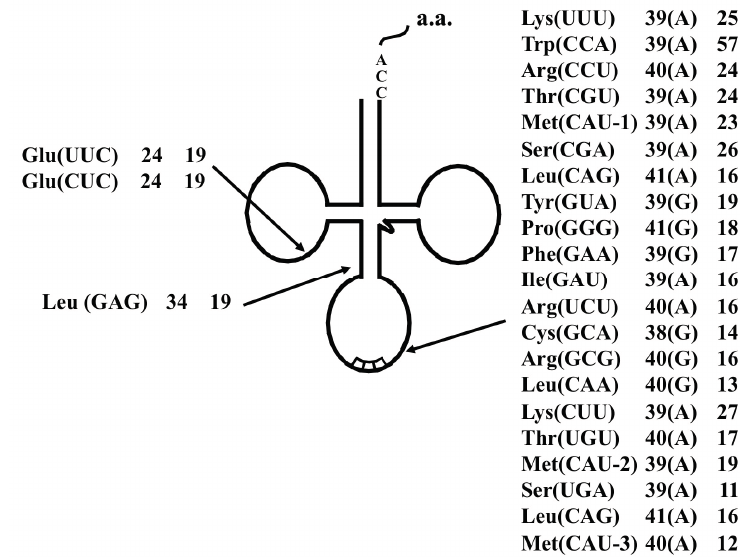
Figure 5. Summary of the tRNA introns identified in S. tokodaii strain7 [15]. Each label includes the tRNA species, the respective intron position relative to the 5' end of respective tRNA, and the lengths of the introns. Characters within parentheses indicate the nucleotide one base 5' from the intron